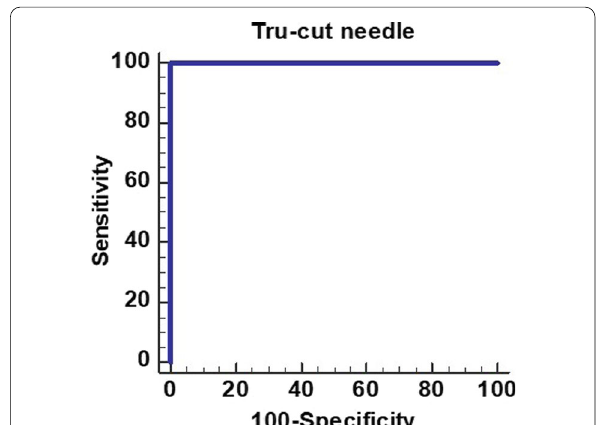
Fig. 6 ROC curve for the accuracy of Tru‑cut needle biopsy in identifying malignant axillary lymph